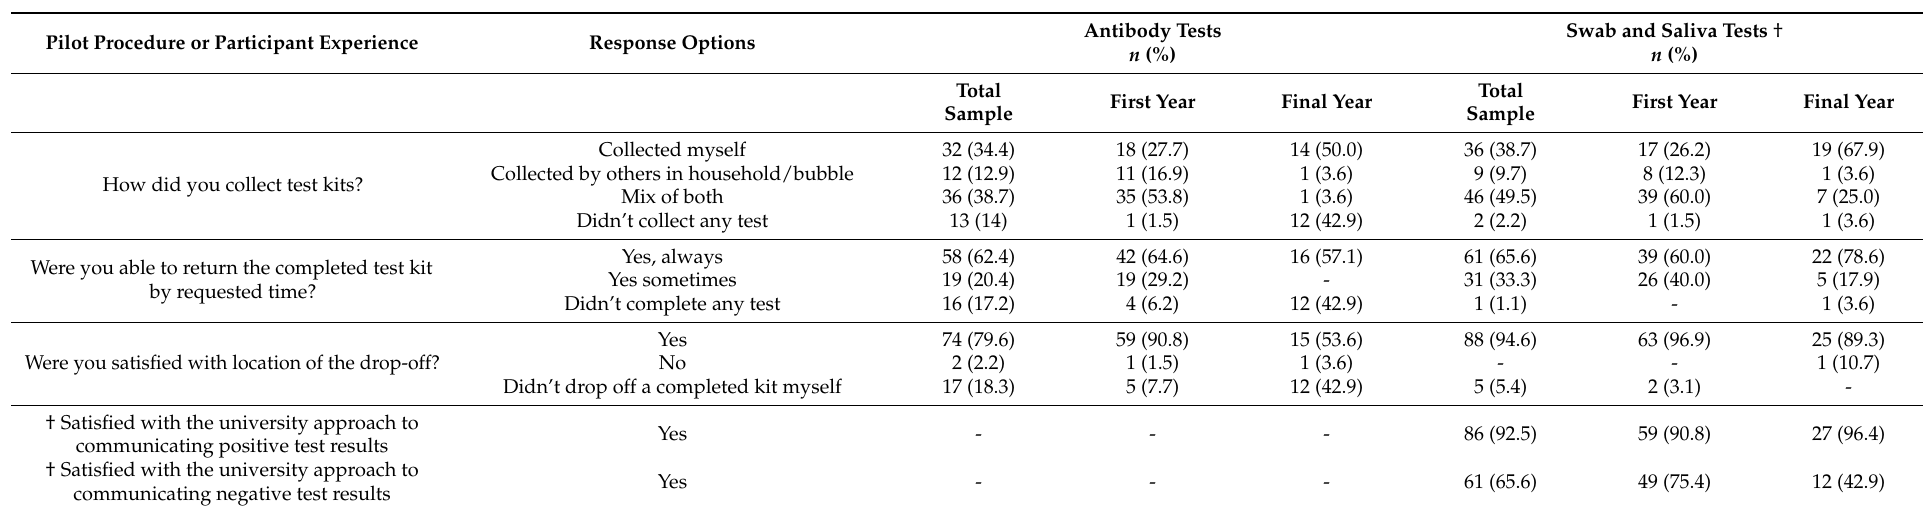
Table 4. Experiences of the P-ATS within and across study sample (total, n = 99; first years, n = 69; final years, n = 30).